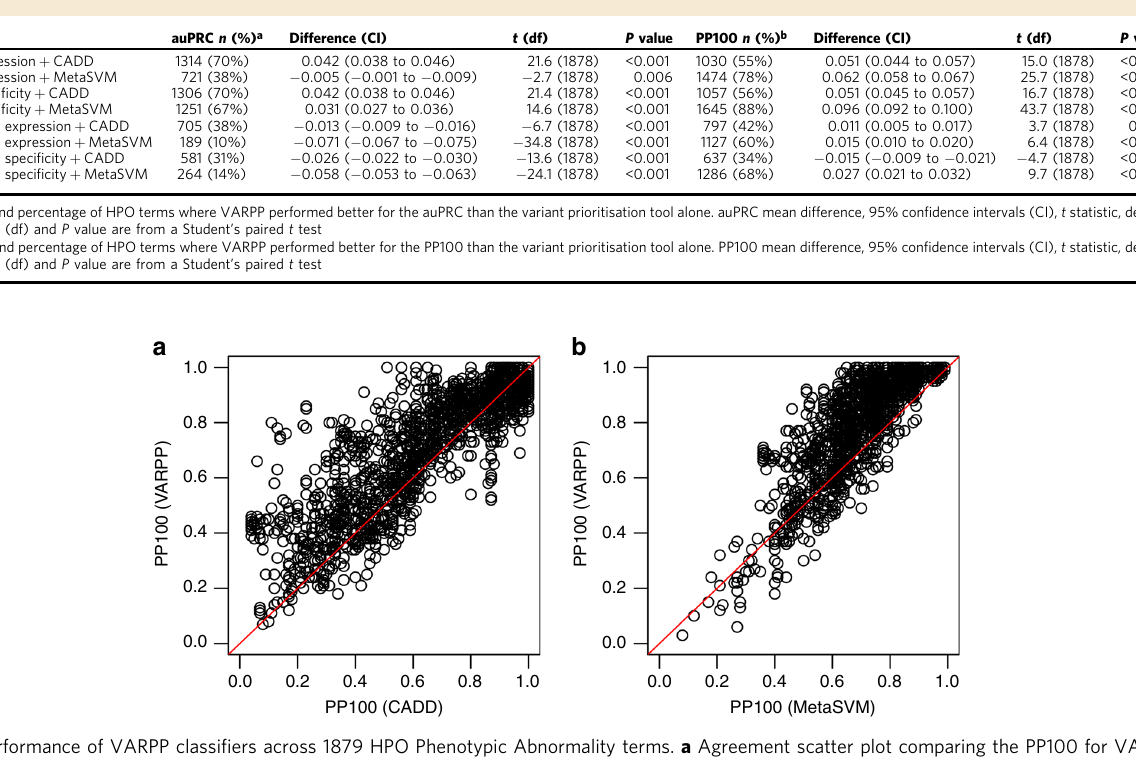
Table 1 Performance of VARPP versus use of variant prioritisation tools alone.